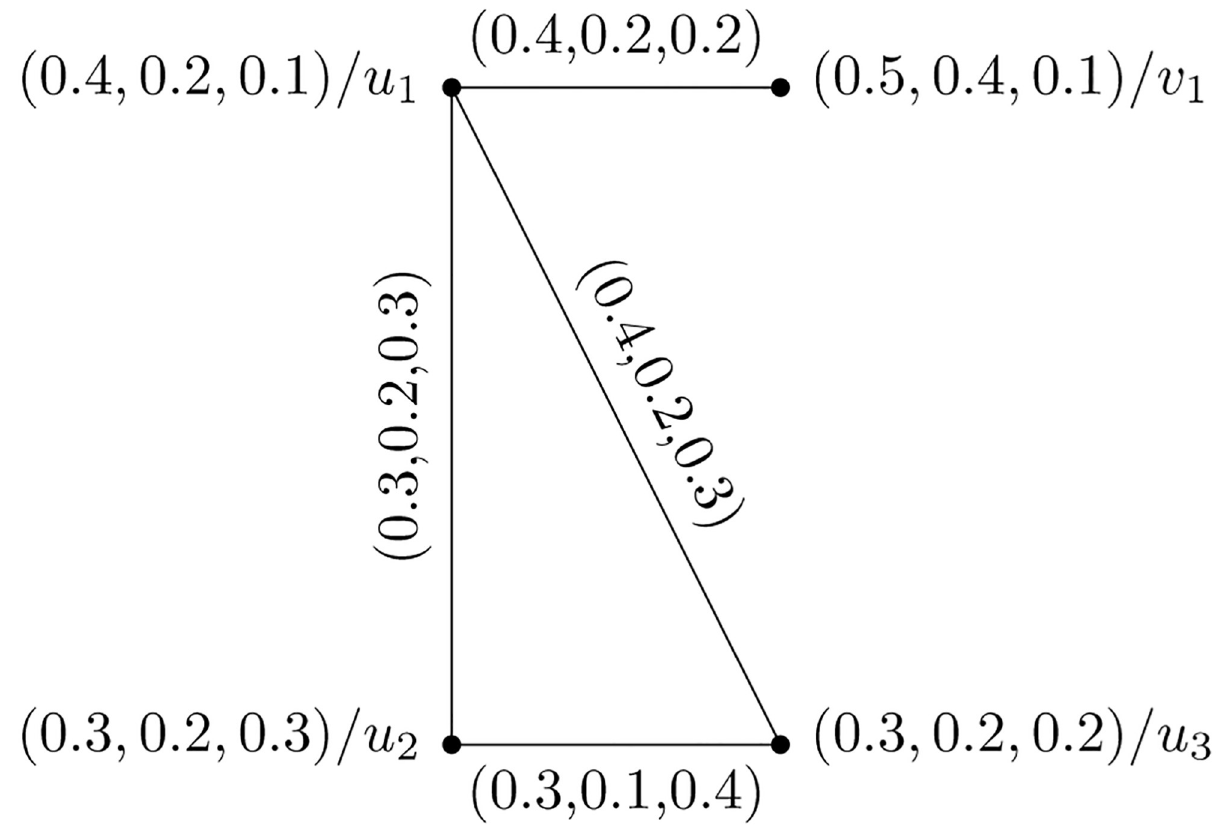
Fig 11. Union of